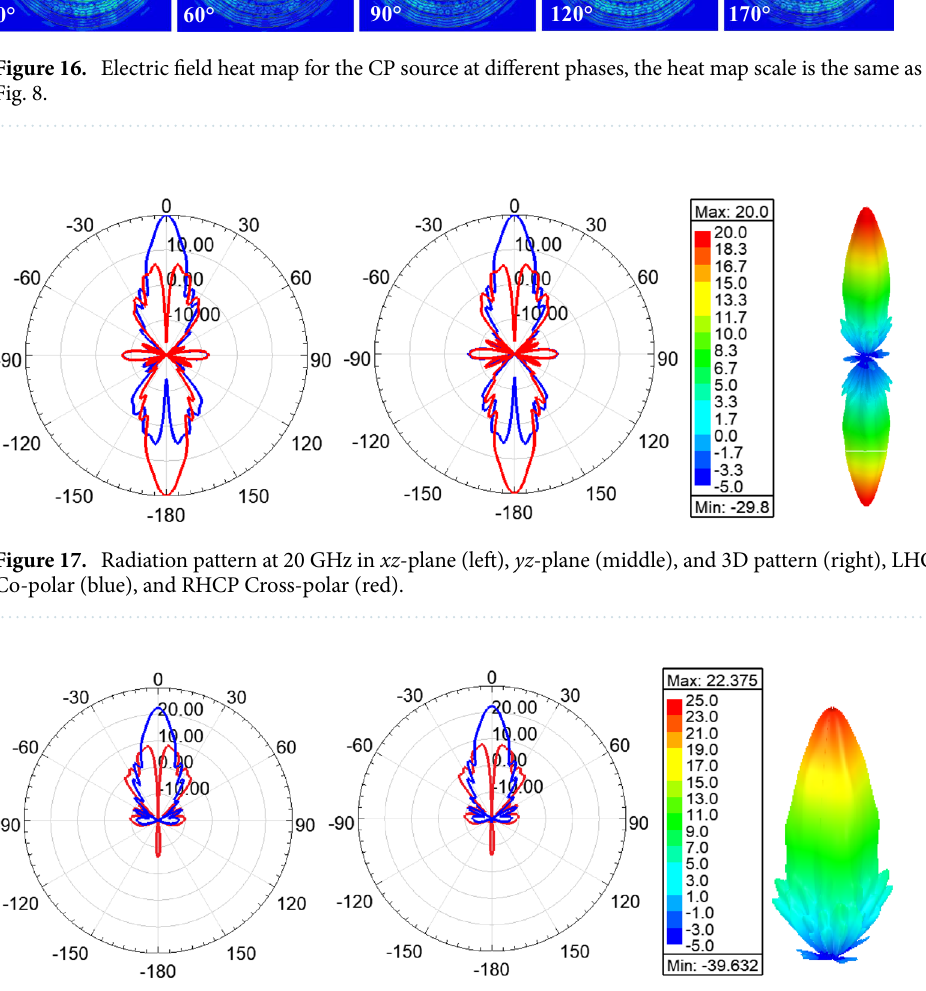
Figure 18. Radiation pattern in at 20 GHz xz -plane (left), yz -plane (middle), and 3D pattern (right), LHCP Co-polar (blue), and RHCP Cross-polar (red) for the PMC